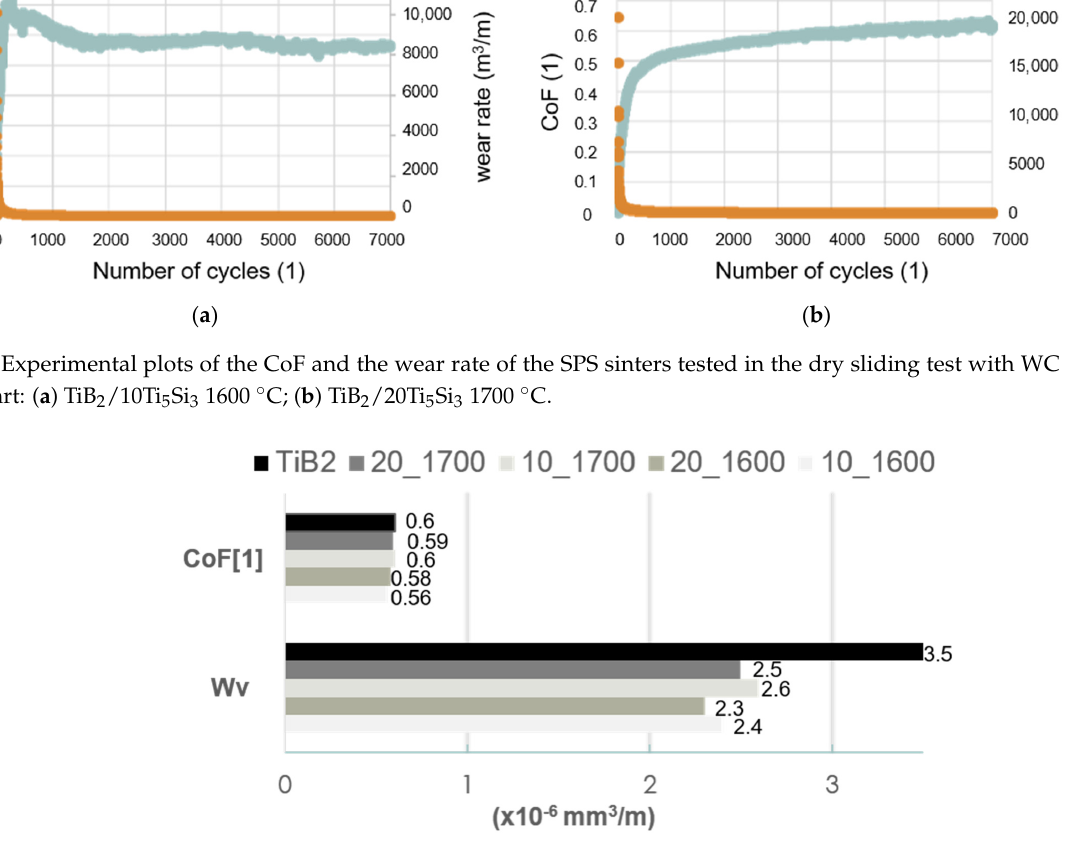
Figure 8. CoF values and volumetric wear indexes (Wv) of the TiB 2 /Ti 5 Si 3 composites determined in friction contact with WC balls loaded at 5 N.